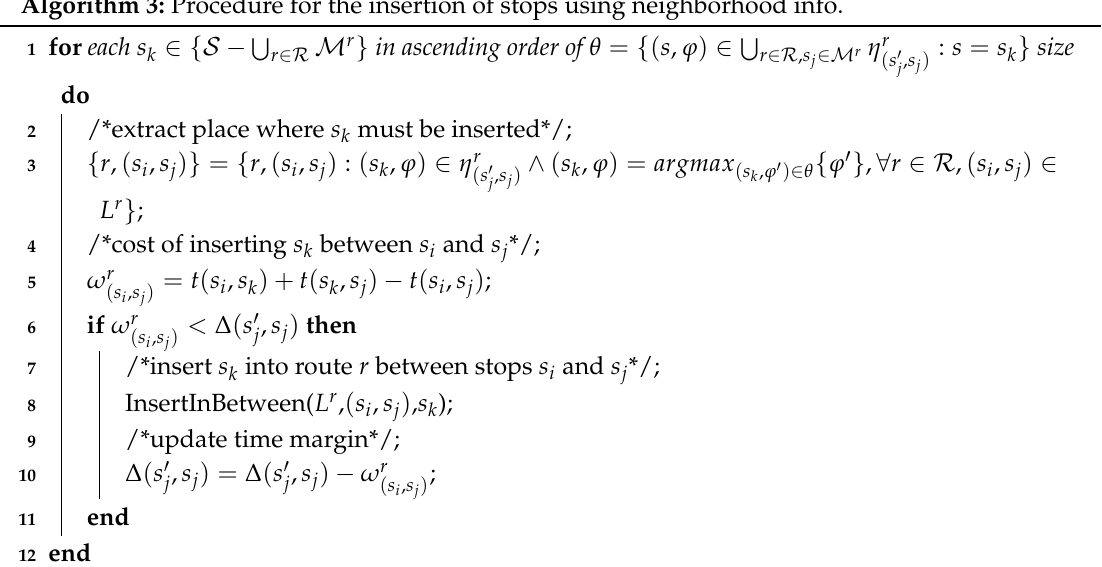
Algorithm 3: Procedure for the insertion of stops using neighborhood info.